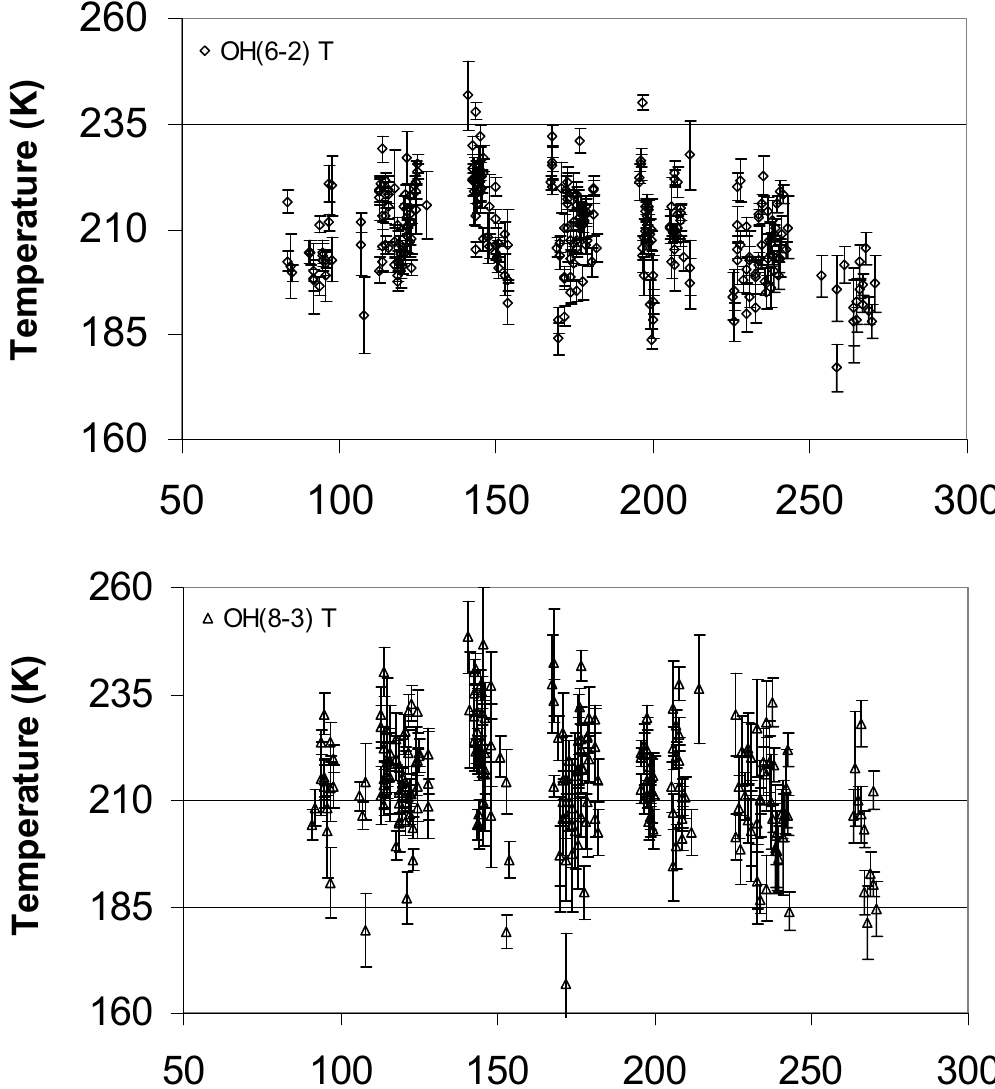
Fig. 5. OH(6–2) and OH(8–3) rotational temperatures determined from spectra collected at Davis in 1990, with ± one sigma